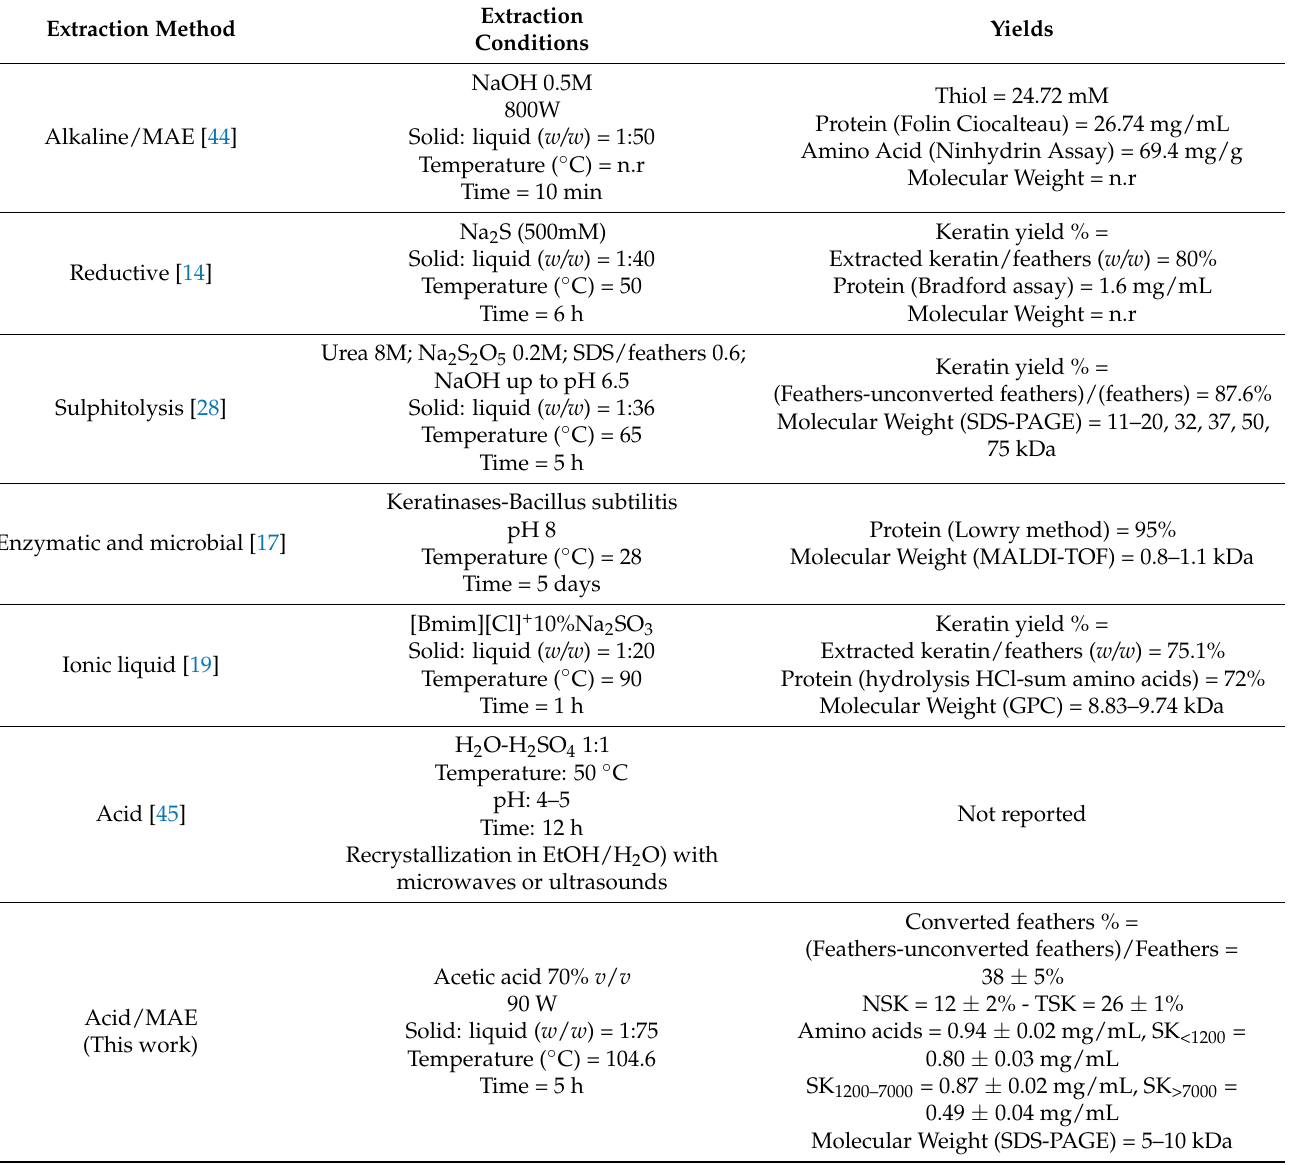
Table 5. Summary of the literature data related to extraction procedures of keratin from waste feathers. Extraction Method